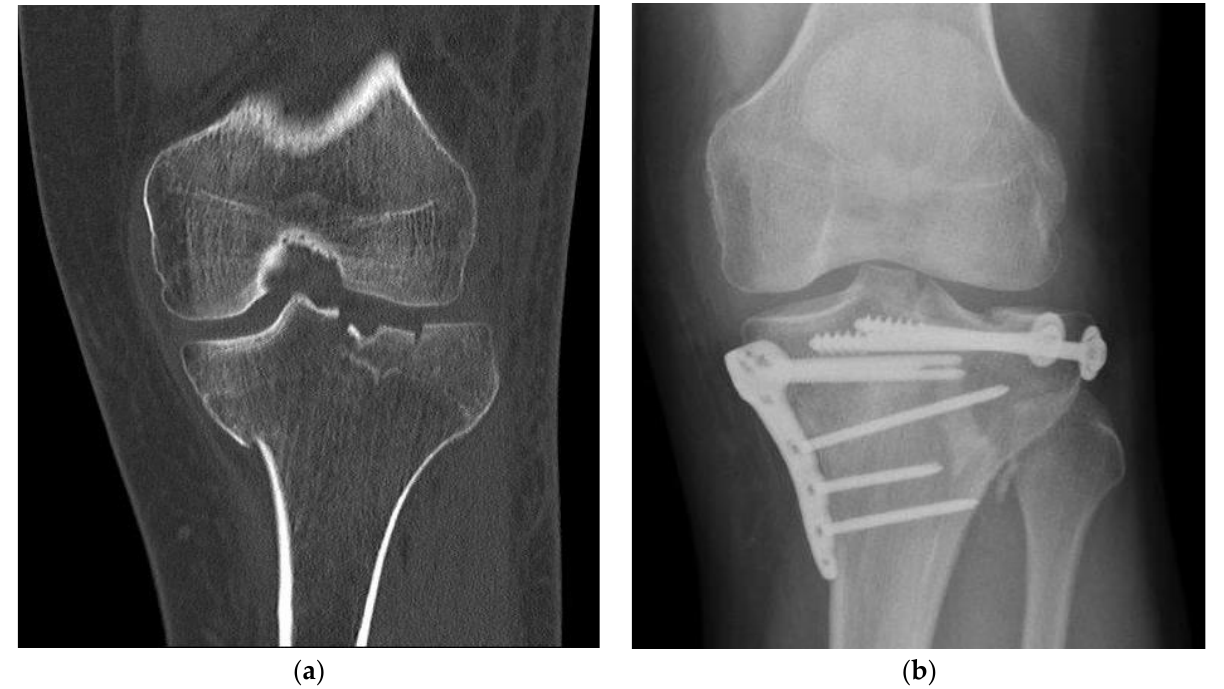
Figure 2. Fracture treatment of a proximal tibial fracture by surgical bone substitute material augmentation: ( a ) Preoperative CT scan demonstrates a metaphyseal compression fracture with intra- and extraarticular fracture gaps; ( b ) Alloplastic bone material substitute augmentation replaces the bone material of the fracture vault defects.